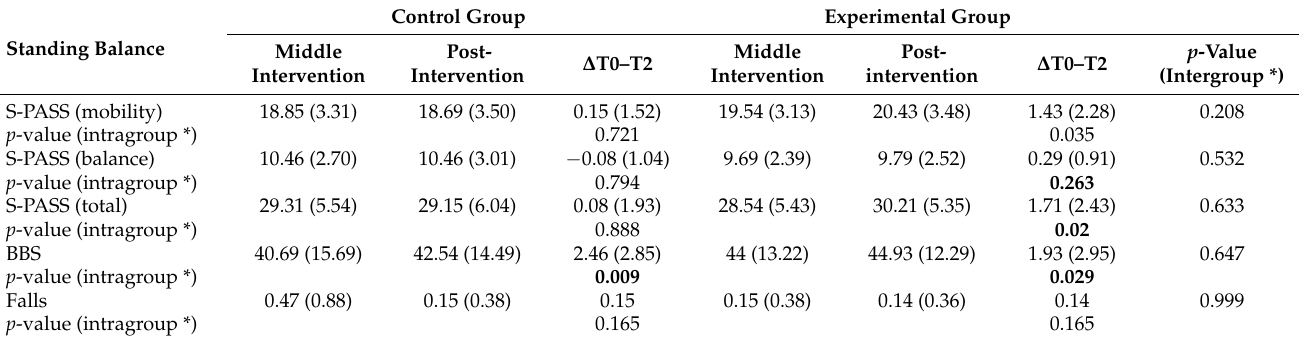
Table 3. Balance outcome measures, standing balance middle and